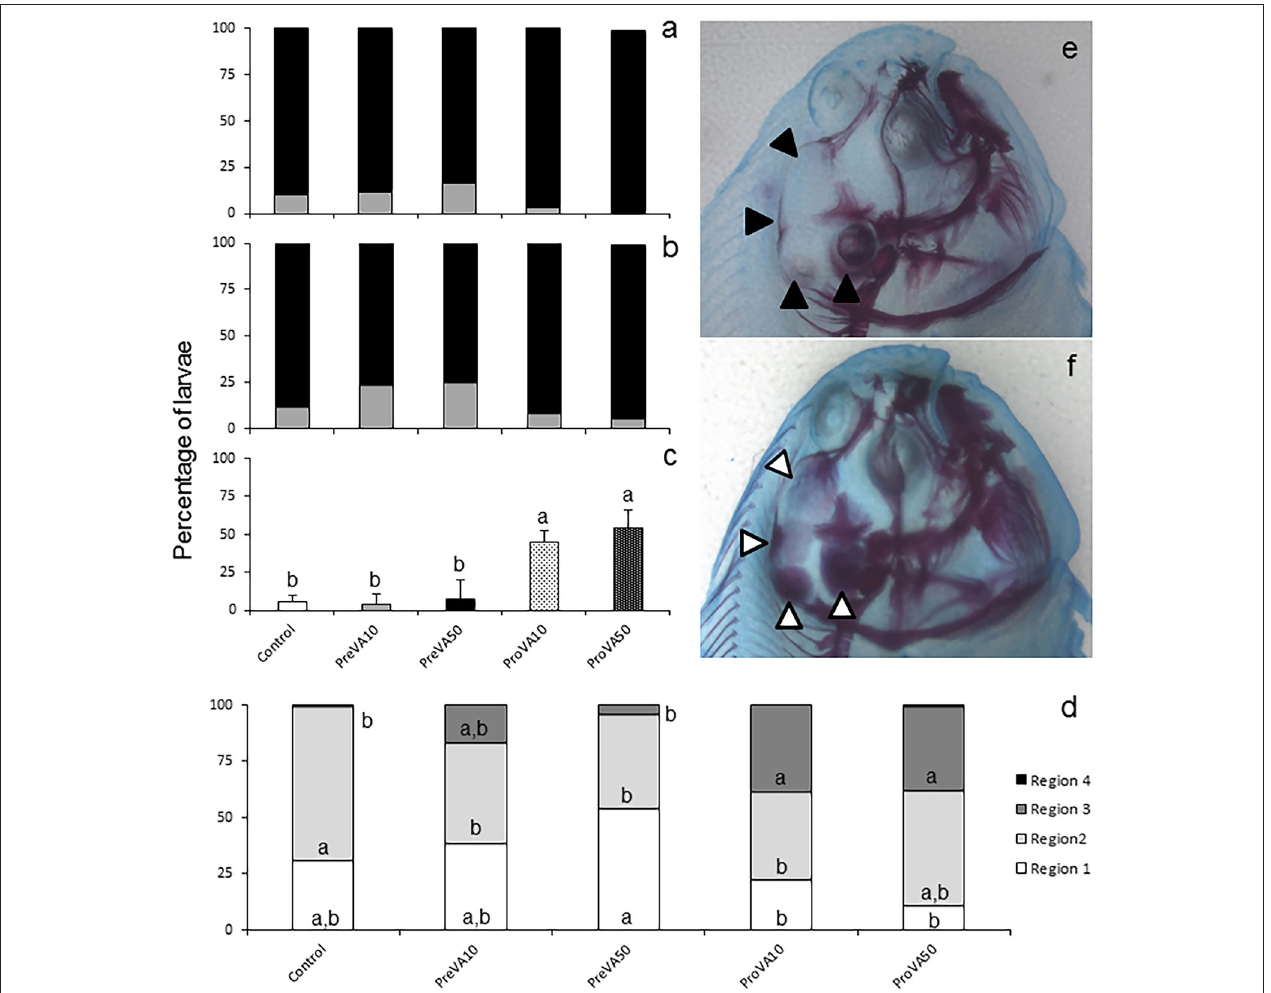
FIGURE 4 | Mineralization degree of different skeletal structures in 21 dph Senegalese sole larvae fed with increased dietary vitamin A levels at different developmental stages. Percentage of larvae showing different degrees of mineralization (showing fully mineralized (black bar fraction), slightly mineralized (gray bar fraction) and not mineralized (white bar fraction) structures) of upper jaw (a) and lower jaw (b) . Percentage of larvae showing an onset of mineralization in closely related axial structures (hyoid, interhyal, pre-opercular and quadrate) (c) , and in defined cranial regions (R1, R2, R3, and R4; please see further information in Supplementary Figure 2) (d) . A detailed view of the degree of mineralization of several cranial structures from Control (e) and ProVA50 (f) larvae at 21 dph is presented. Note the extended alizarin red staining in several cranial regions when comparing Control (black arrow heads) with ProVA50 (white arrow heads) larvae. For a detailed description about the different experimental groups, please see the legend of Figure 1 . Different letters within white, light gray, strong gray and black bar fraction in graph (d) or at the top of each bar in graph (c) denotes statistically significant differences among experimental groups (ANOVA, P < 0.05; N = 3).